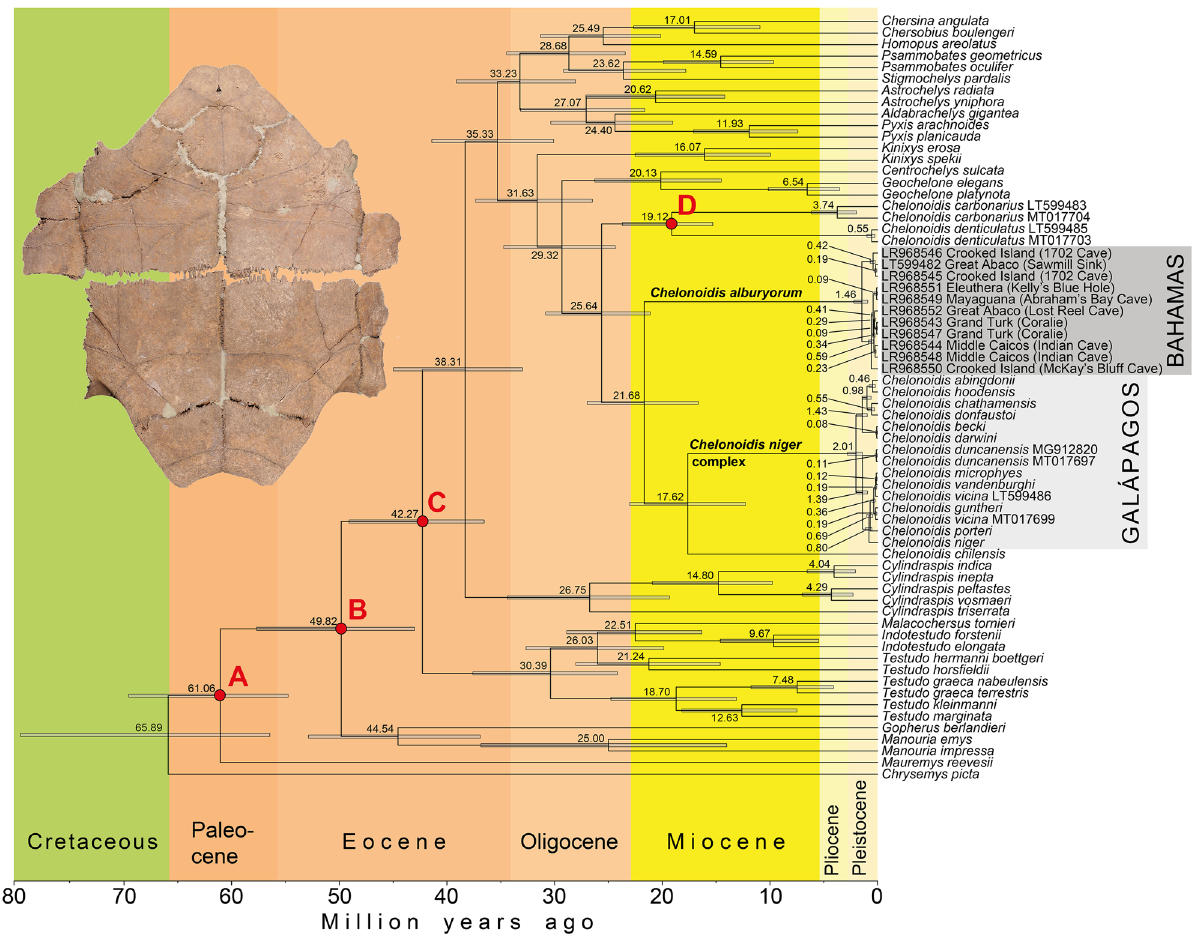
Figure 3. Fossil-calibrated time tree for near-complete mitochondrial genomes (15,516 bp) of all extant and some extinct tortoise genera. Codes following species names or preceding localities are GenBank/ENA accession numbers (for remaining accession numbers, see Supplementary Information). Inferred mean ages and 95% Highest Posterior Density intervals are shown for each node. The red circles indicate fossil-based constraints following Kehlmaier et al. 34 : ( A ) Hadrianus majusculus , 50.3–100.5 Ma; ( B ) Cheirogaster